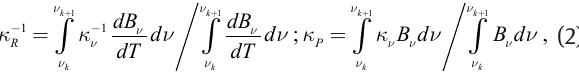
Figure 3: Total absorption coefficient for the SF admixtures of Cu at the temperature of 20 000